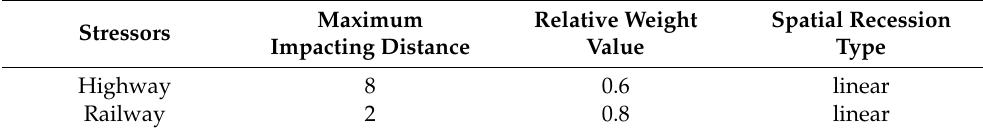
Table 3. Attributes of stressors.